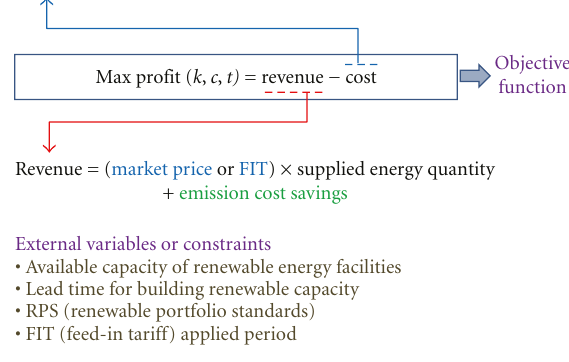
Figure 13: Profit function